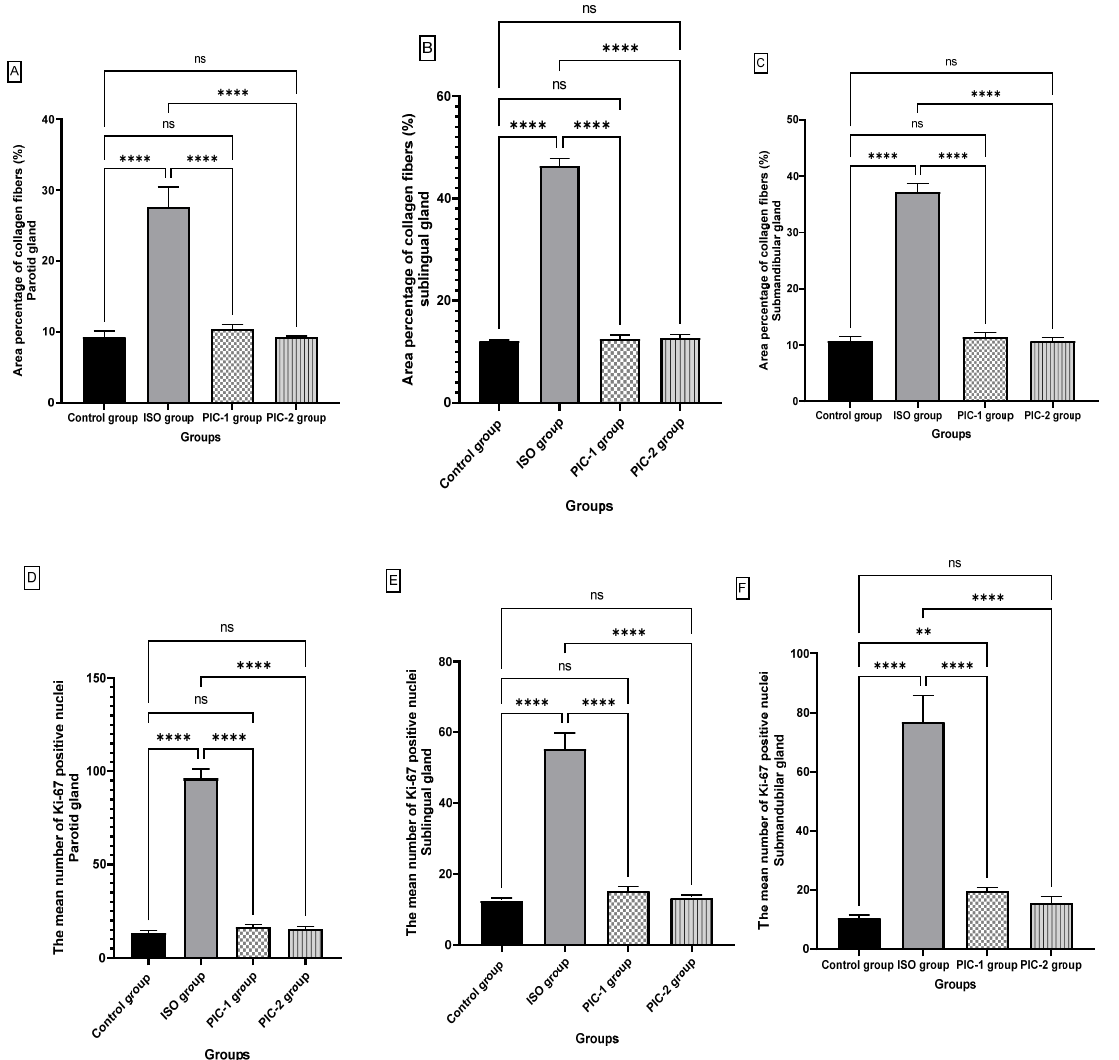
Figure 9. Graph of the mean area %age of collagen fibers (%) in the three salivary glands (parotid ( A ), sublingual ( B ), and submandibular ( C ) glands). The mean number of Ki-67 positive nuclei in the three salivary glands (parotid ( D ), sublingual ( E ), and submandibular ( F ) glands). Data are presented as mean ± SD. Differences between groups were identified using one-way ANOVA, followed by Tukey’s multiple comparison post-hock-test, indicated above the bars. ( n = 8 rat/group). ** p ≤ 0.01, **** p ≤ 0.00001, ns = non-significant to the corresponding group.